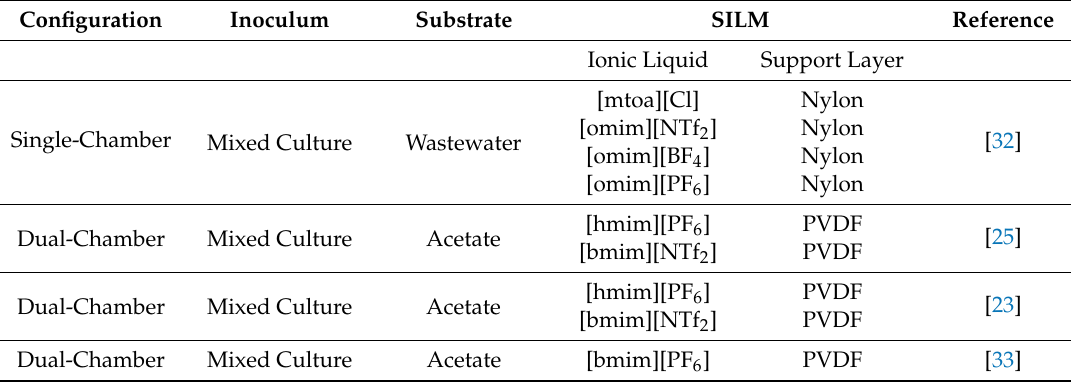
Figure 2. The structure, scheme, and image of a supported ionic liquid membrane (SILM). Table 1. SILMs used in various MFC